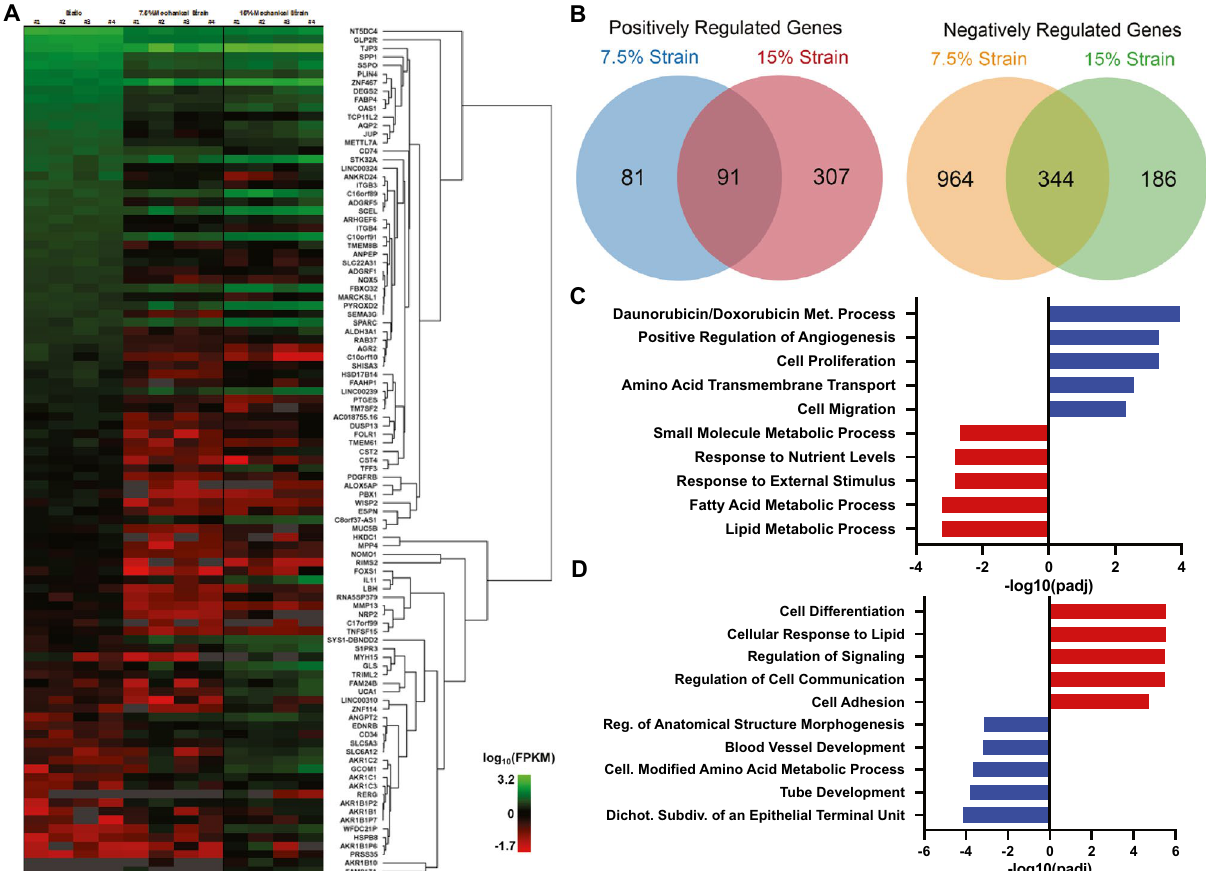
Figure 1. Mechanical strain regulates gene transcription of cell adhesion, drug metabolism and proliferation genes. MDA-MB-231 breast cancer cells were treated with mechanical strain for 24 h at 0, 7.5, and 15% maximal strain at a frequency of 1 Hz. Total RNA was isolated and RNA sequencing was performed (n = 4). ( A ) Hierarchical clustering of the most significantly regulated genes. FPKM = fragments per kilobase of transcript per million mapped reads. ( B ) Venn diagrams for significantly regulated genes in the 7.5% and 15% mechanical strain groups. ( C ) The top five most upregulated and downregulated gene ontology groups for cells treated with 7.5% strain. ( D ) The top five most upregulated and downregulated gene ontology groups for cells treated with 15% strain. R software was used to create parts of this figure 22